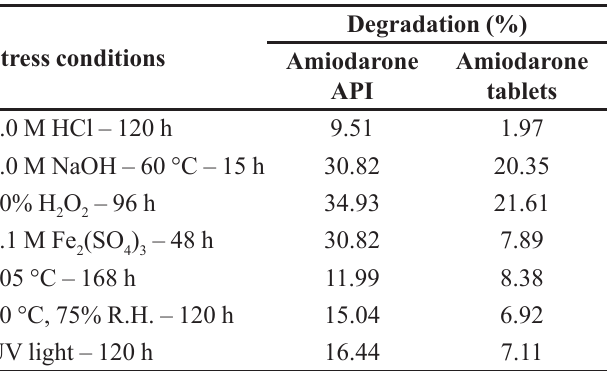
TABLE II - Results obtained in the forced degradation study for amiodarone API and tablets